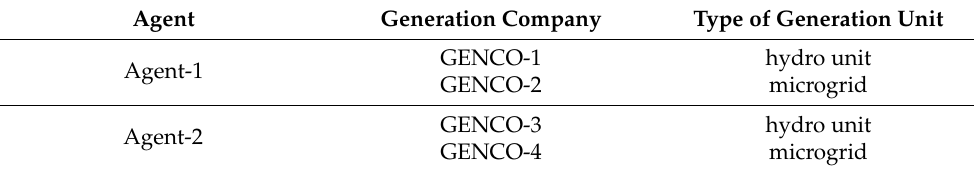
Table 2. Participation of DISCOs.